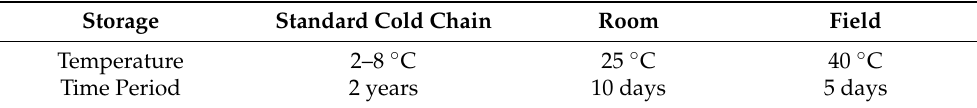
Table 1. Temperature values and time periods to be used as minimum requirements for thermotoler- ance, as recommended at the Peste des Petits Ruminants Global Eradication Programme (PPR-GEP) thermotolerant (TT) vaccines workshop. These values refer to storage after dilution of the freeze-dried vaccines with